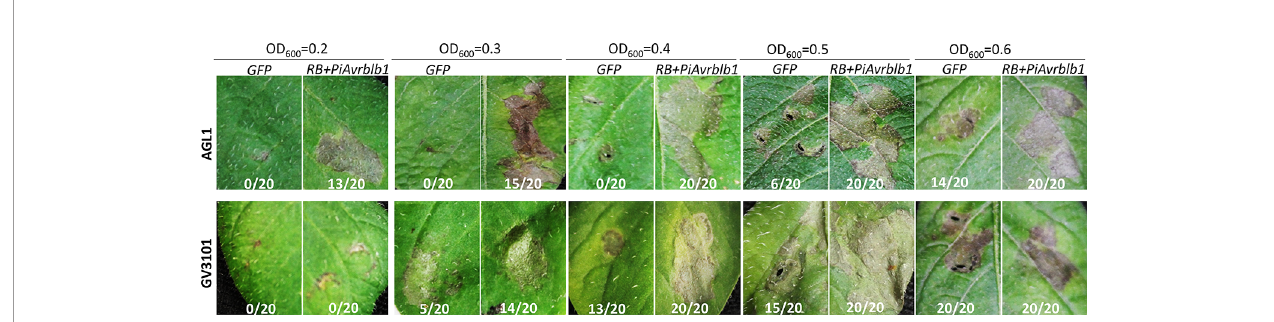
FIGURE 1 | Speci fi c hypersensitive response (HR) mediated by recognition of P. infestans Avr genes in potato is affected by strains used for A. tumefaciens in fi ltration. Strains AGL1 and GV3101 were examined with different optical densities, OD 600 of 0.2, 0.3, 0.4, 0.5 and 0.6, in the potato differential genotype R3 . Co- in fi ltration of agrobacteria carrying PiAvrblb1 and RB was used as a positive treatment, while an A. tumefaciens carrying Green Fluorescent Protein gene ( GFP ) was in fi ltrated as a negative control. The number of HR sites/total number of in fi ltration sites were indicated. The experiment was repeated three times with 20 replicates. Pictures were taken at 5 – 7